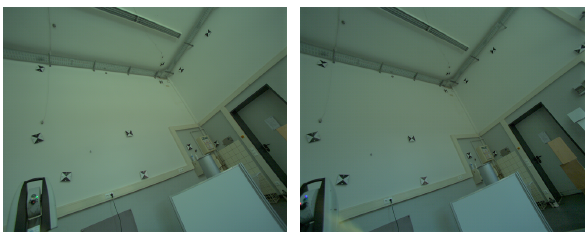
Figure 4. Images of the right camera in station 1 (left) and 2